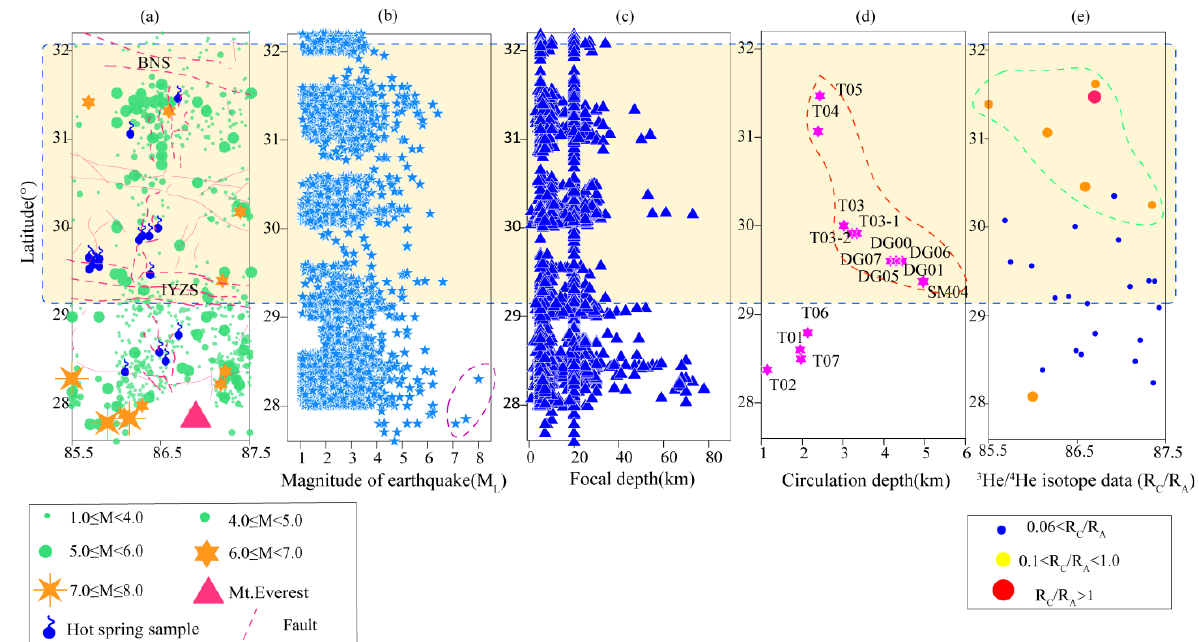
Figure 7. Spatial distribution of circulation depth of samples along the TNR and earthquakes:( a ) the spatial disribution of spring and earthquake; ( b ) the magnitude of earthquake; ( c ) the spatial disribution of focal depth; ( d ) the circulation of springs; ( e ) the value of 3 He/ 4 He isotope (R C /R A ) and data from Klemperer et al. [11].